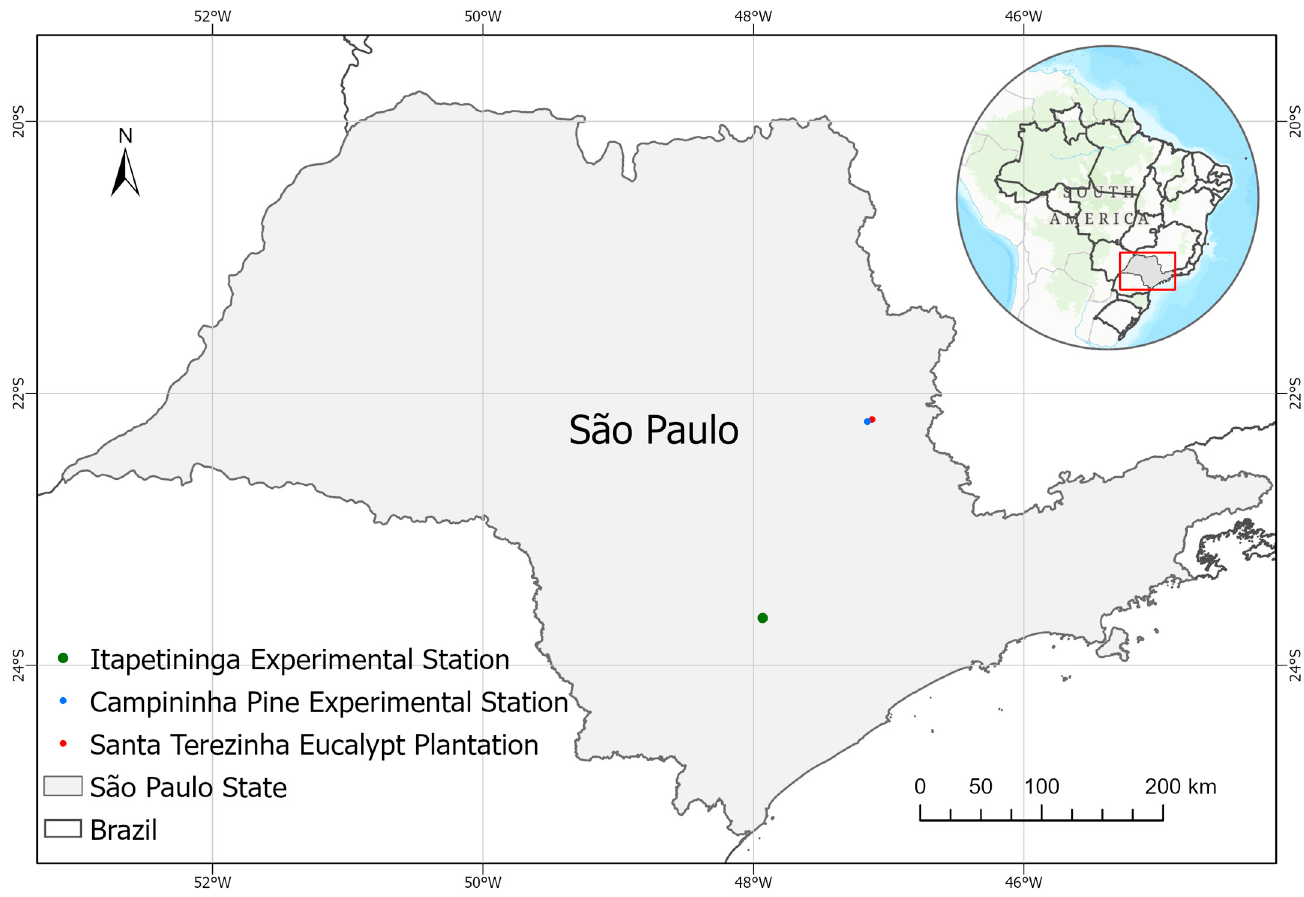
Figure 1. Location of the study area, S ã o Paulo State, within Brazil. The pilot areas are highlighted in the figure.